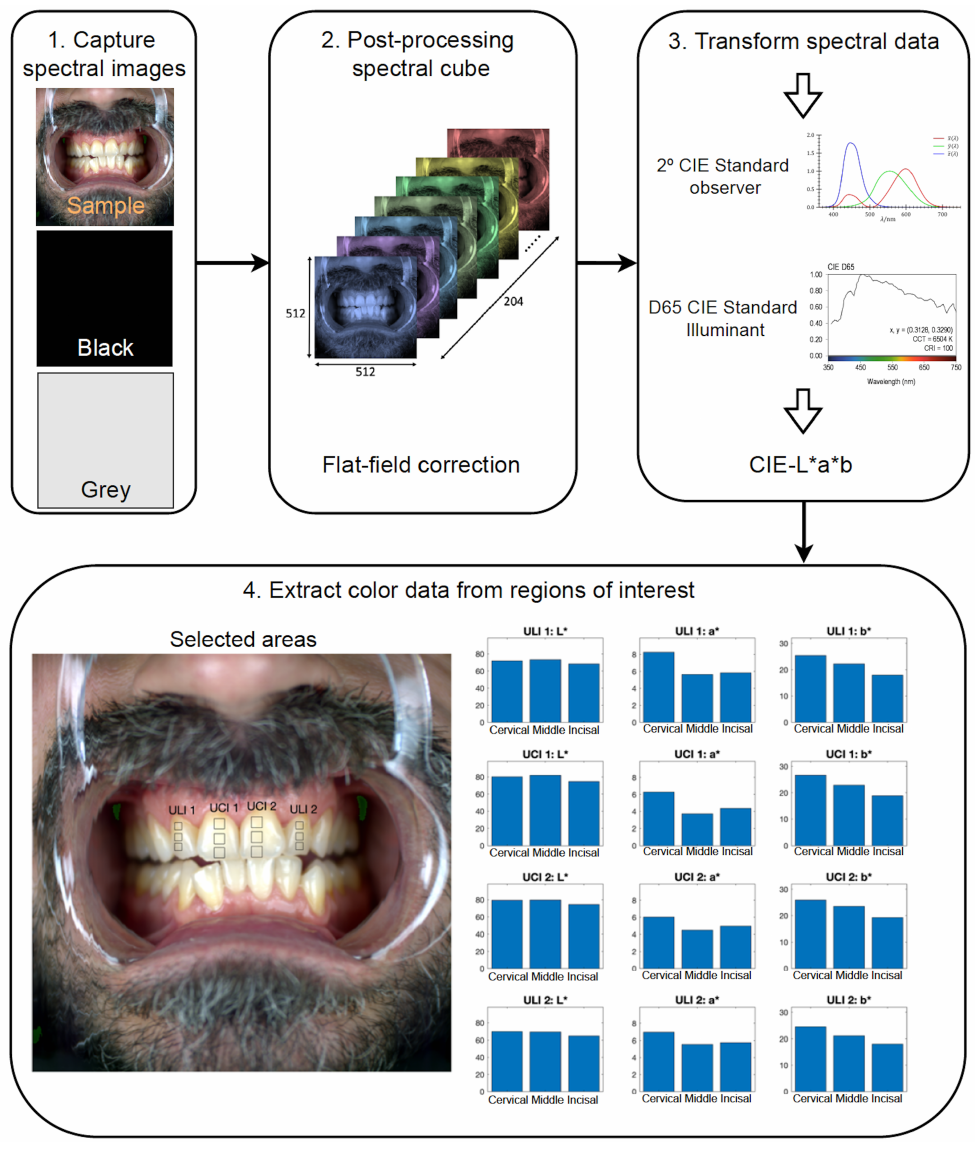
Figure 2. Workflow scheme of the spectral image capturing protocol, data processing and CIE L*, a* and b* values extraction corresponding to the cervical, middle and incisal thirds.